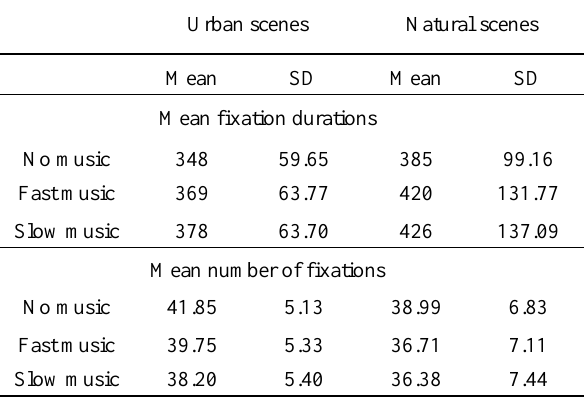
Table 1. Mean scores for the fixation durations in milliseconds and the number of fixations for each experimental condition (no music, slow music, fast music) and the type of scene (urban,